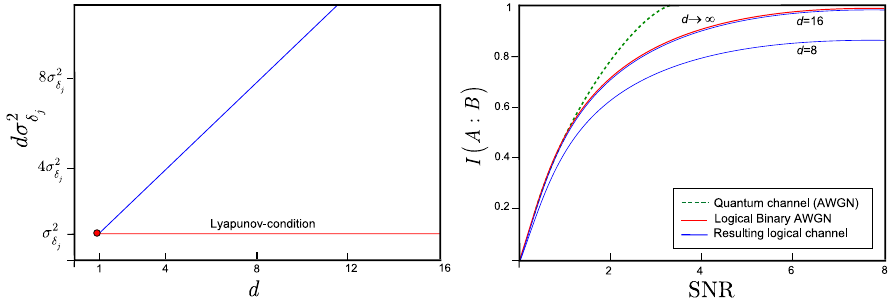
Figure 6. ( a ) The Signal-to-Noise Ratio (SNR) of the resulting logical binary channel is maximized by the Lyapunov-condition (red line). It makes possible to convert the physical Gaussian quantum channel to a logical channel with the same noise variance for arbitrary d . For the blue line the Lyapunov-condition is not satisfied. ( b ) The capacity of the logical channel for various dimensions. At low SNRs the capacity of the physical Gaussian quantum channel (dashed line) coincidences with the capacity of the binary Gaussian channel (red). For d = 16, the capacity of the logical channel is very close to the capacity of a binary Gaussian channel, and at low SNRs it perfectly coincidences with the capacity of the Gaussian quantum channel. The reconciliation efficiency at d = 16 is β = 0.97. The curves for lower d -s do not exist because the resulting logical channels are not Gaussian, since the Lyapunov-condition is not satisfied in the